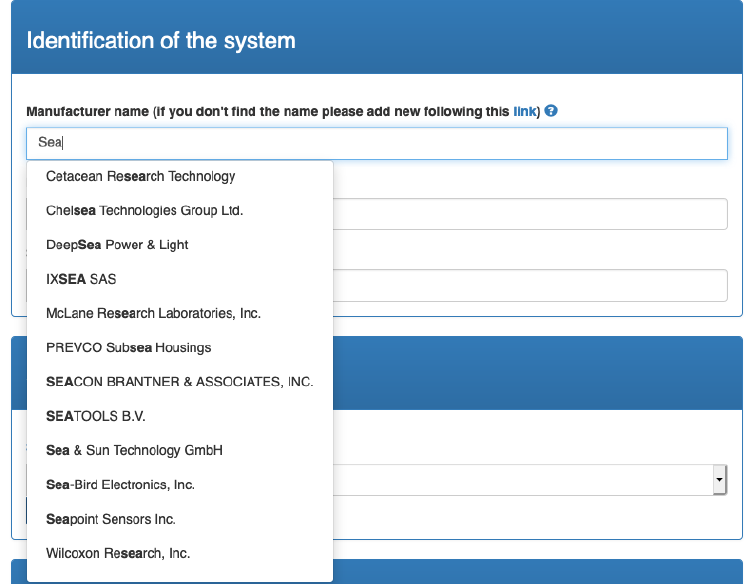
Figure A2. EDI web form rendering of autocompletion options retrieved by the first SPARQL query in Listing